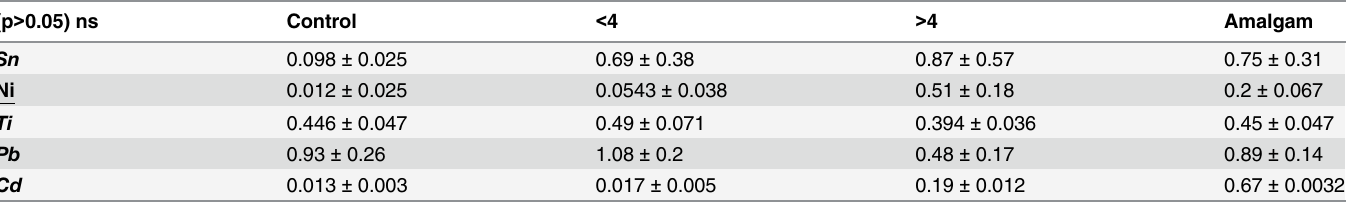
Table 1. The analysis of the dental filling number and levels of other heavy metal levels in hair did not shown significant differences between both amalgam groups (total number of amalgams; Pooled; n = 42); > 4 (n = 15) or < 4 (n = 27), as compared to controls (n = 13). (p > 0.05) ns